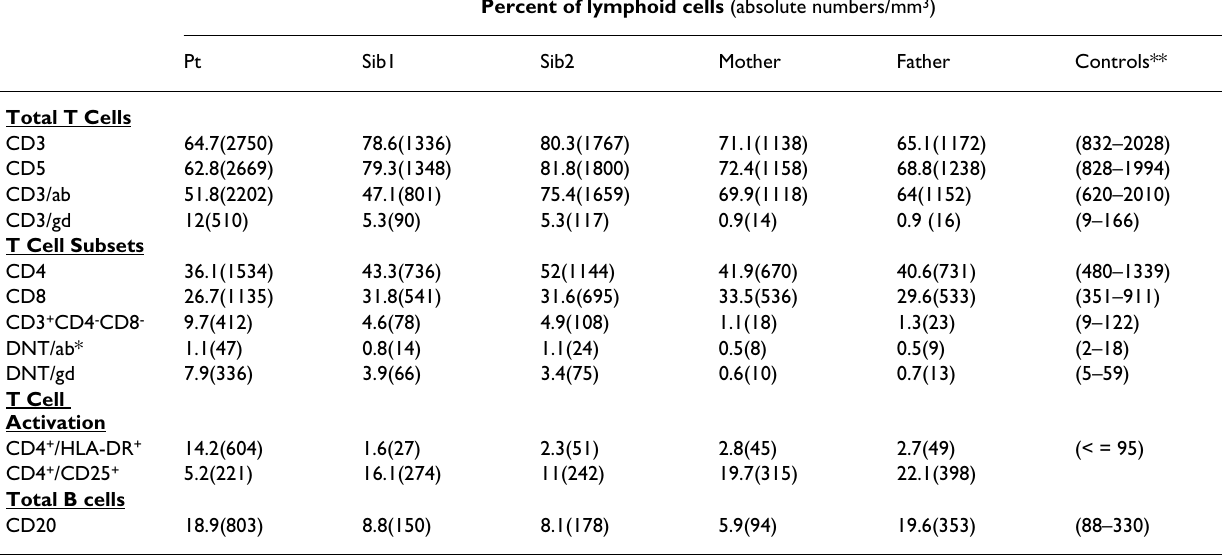
Table 2: Lymphocyte subpopulations in members of family 86 Percent of lymphoid cells (absolute numbers/mm 3